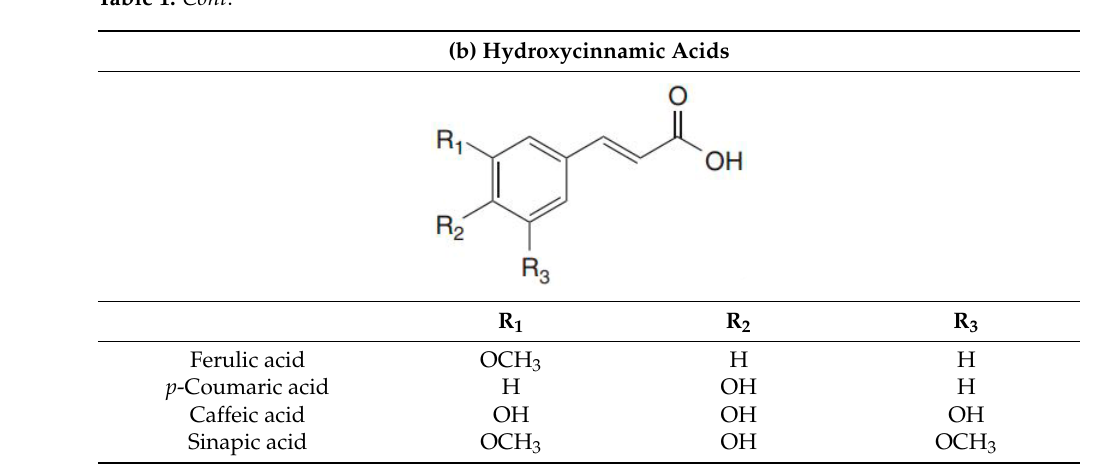
In Table 2, we have reviewed four hydroxybenzoic acids and four hydroxycinnamic acids found in whole grains. Hydroxybenzoic acids include p -hydroxybenzoic, gallic, vanillic and syringic acids. p -Hydroxybenzoic is found in oats, rice, buckwheat, wheat and barley [39]. The average range of p -hydroxybenzoic found in wheat is 7.5 µ g/g and in barley is 110.7 µ g/g. Gallic acid is distributed in wheat, barley, oats, rice [40] and buckwheat [39]. Among other grains, oats have the highest content (121.5 µ g/g) while buckwheat has the lowest (36.8 µ g/g). Vanillic acid is found in wheat, barley, oats, rice [40] and buckwheat [39]. The average content ranges from 7.2 µ g/g in buckwheat to 19.6 µ g/g buckwheat [44], and its content was the highest in buckwheat, at 49.9 µ g/g, and the lowest